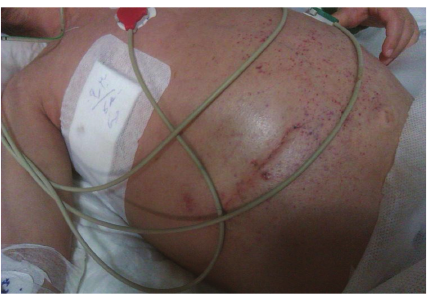
Figure 1: Large abdominal mass and petechiae, purpura due to DIC in patient with neuroblastoma.